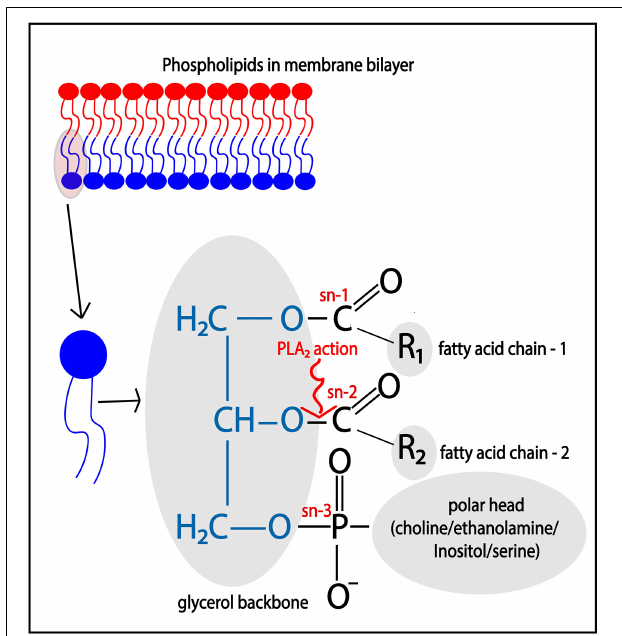
FIGURE 2 | Catalytic action of PLA 2 . Membrane phospholipids such as phosphatidylcholine (PC)/phosphatidylethanolamine (PE)/phosphatidylinositol (PI), and phosphatidylserine (PS), are cleaved at the sn -2 position of the glycerol backbone by the action of PLA 2 , thereby releasing free fatty acid such as arachidonic